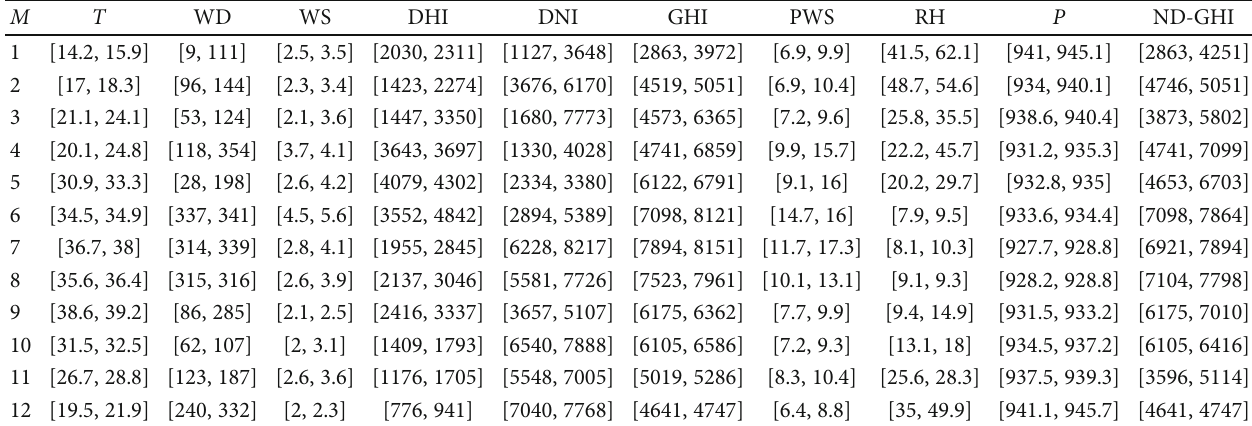
Table 1: The solar